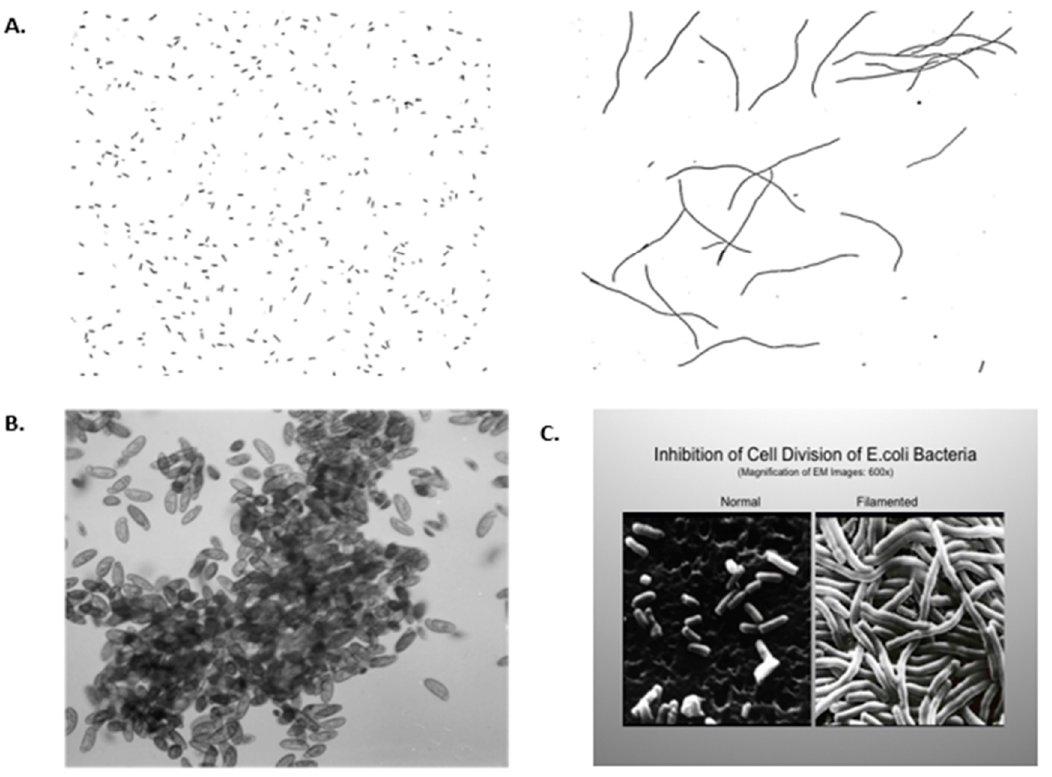
Figure 1. ( A ) Filamentation of aerobically grown Hpx-mutants of Escherichia coli ( E. coli) cells. Cells were grown in Luria broth anaerobically ( A ) or aerobically ( B ). Magnification: × 400. [35] Permission granted by Proc Natl. Acad. Sci., (PNAS). ( B ) J.M. Saul, Lethaia, 2008: Clumping of anaerobic cilates in oxygenated water [36]. Permission granted by Les 3 Colonnes, Paris. ( C ) E. coli , grown in traditional growth medium, showing normal morphology. Magnification: × 600. When E. coli were grown in the same medium but with a submerged platinum electrode, the E. coli had their DNA replicate, but they did not septate. This observation led to Dr. Barnett Rosenberg’s discovery of the anti-cancer drug cisplatin [37]. Permission granted by: Paul Rosenberg of the Board of Barros Foundation. Permission granted by Springer Nature, N.Y.